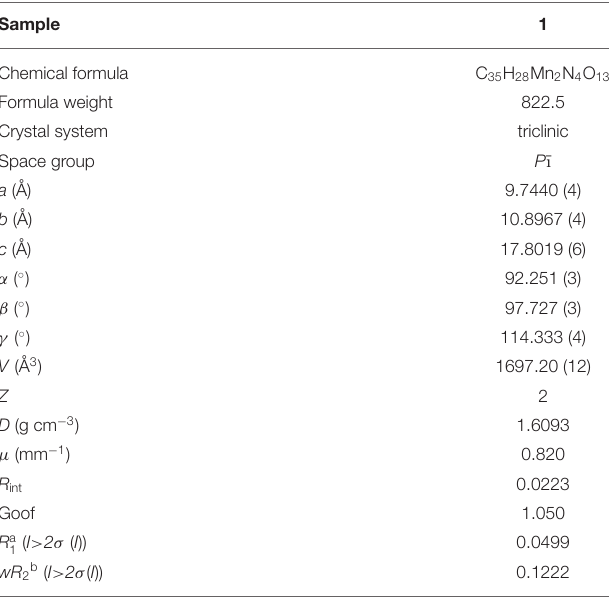
TABLE 1 | Crystallographic data for 1 .